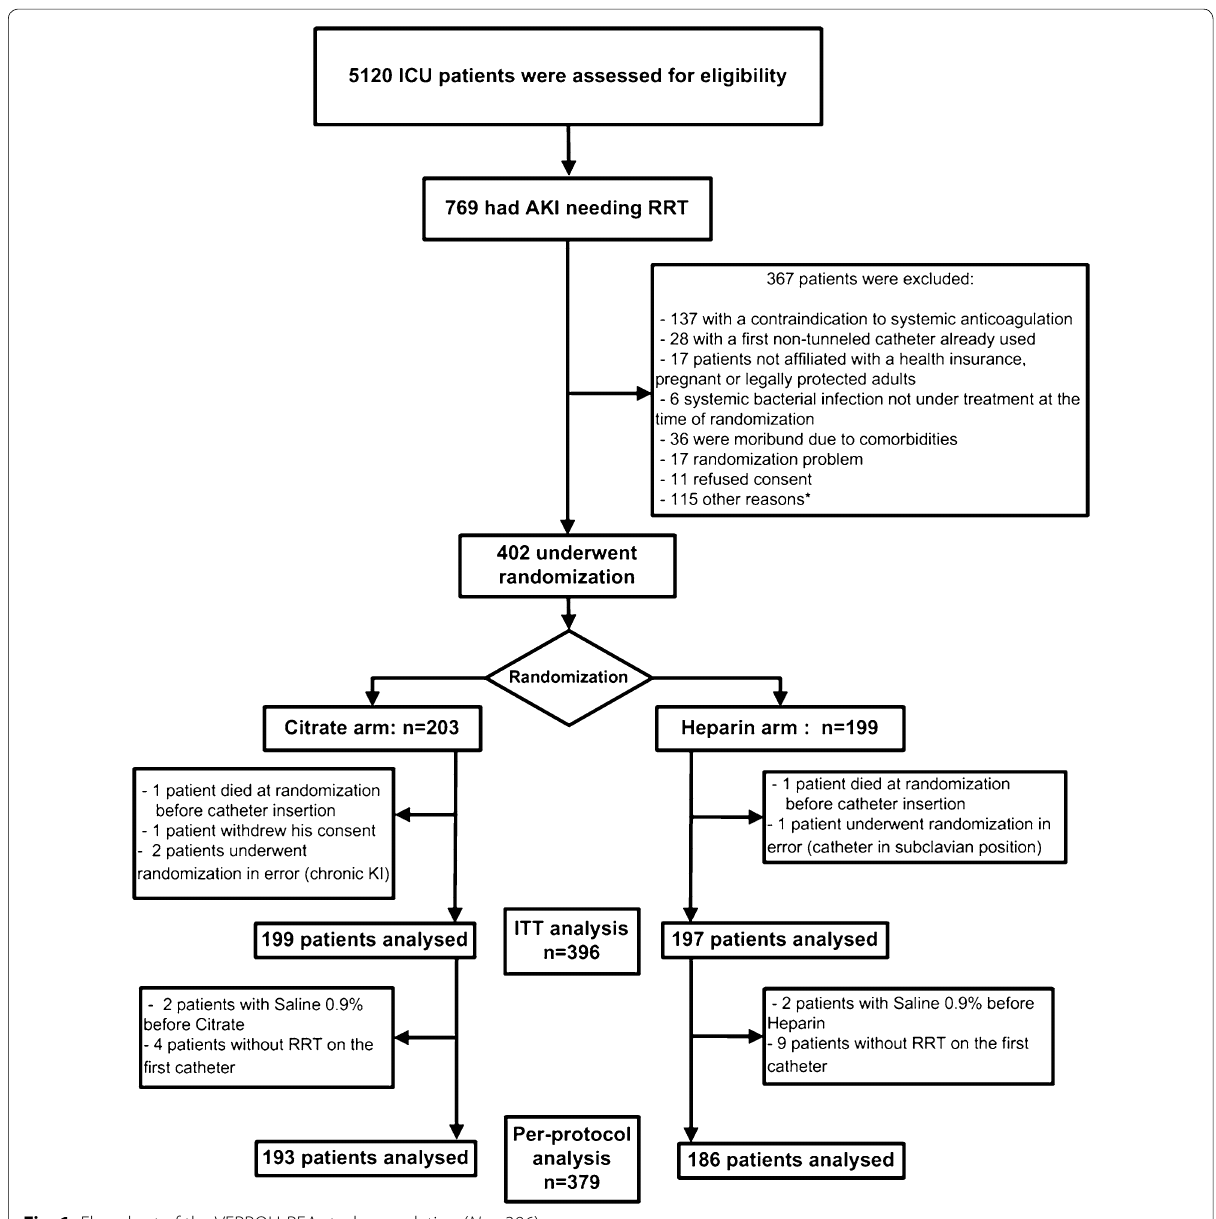
Fig. 1 Flowchart of the VERROU‑REA study population ( N